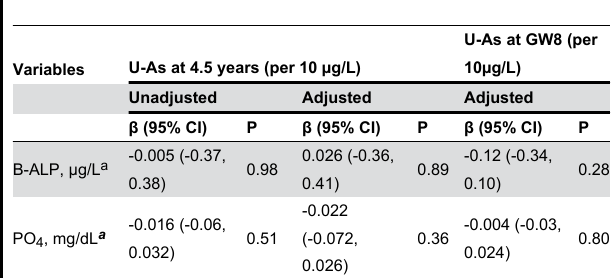
Table 4. Linear regression analysis of plasma biomarkers in relation to concurrent and prenatal arsenic exposure in all children, boys and girls at 4.5 years